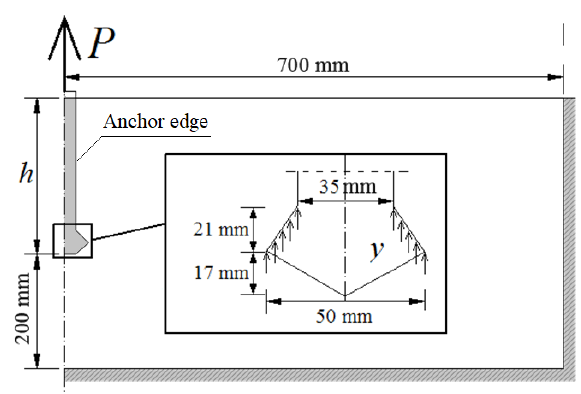
Figure 3: Scheme of the